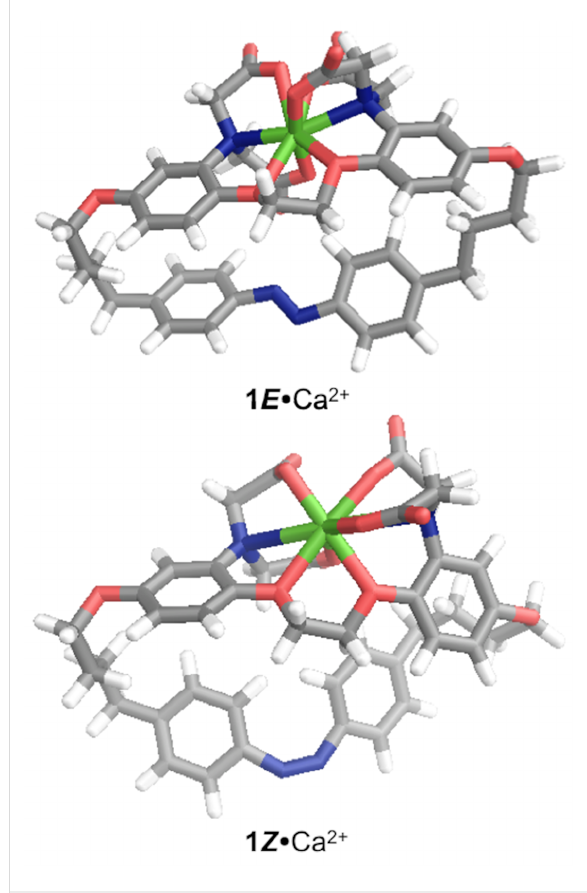
Figure 2: Energy-minimized molecular modelling structures of 1 E• Ca 2+ and 1 Z• Ca 2+